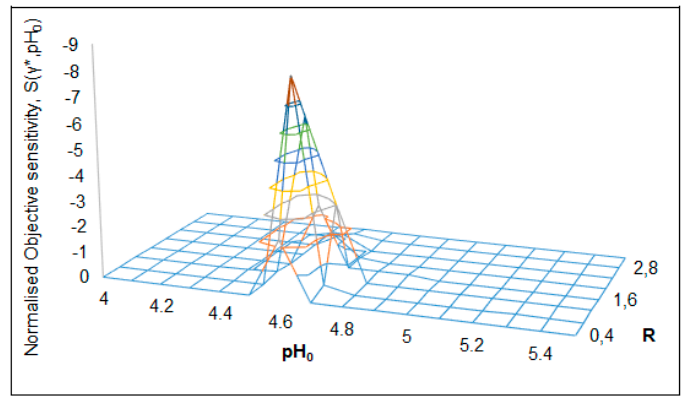
Figure 10. Normalized objective sensitivity S( γ *, pH0) as a function of parameters R and pH 0 .